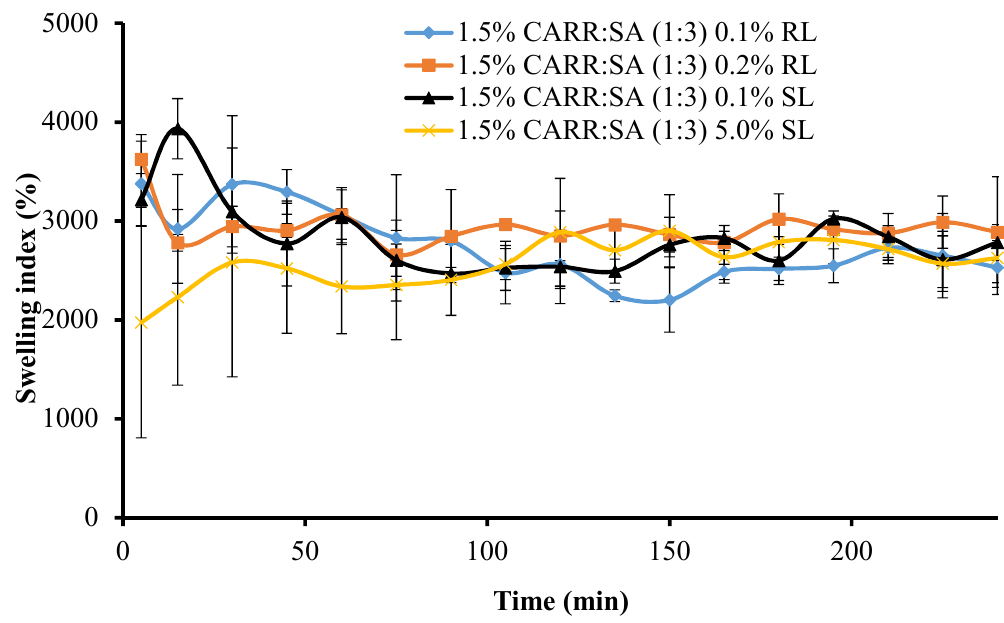
Figure 5. Swelling profiles in SWF, pH 7.5 of 1.5% CARR:SA (1:3) wafers loaded with 0.1% RL, 0.2% RL, 0.1% SL and 5% SL.